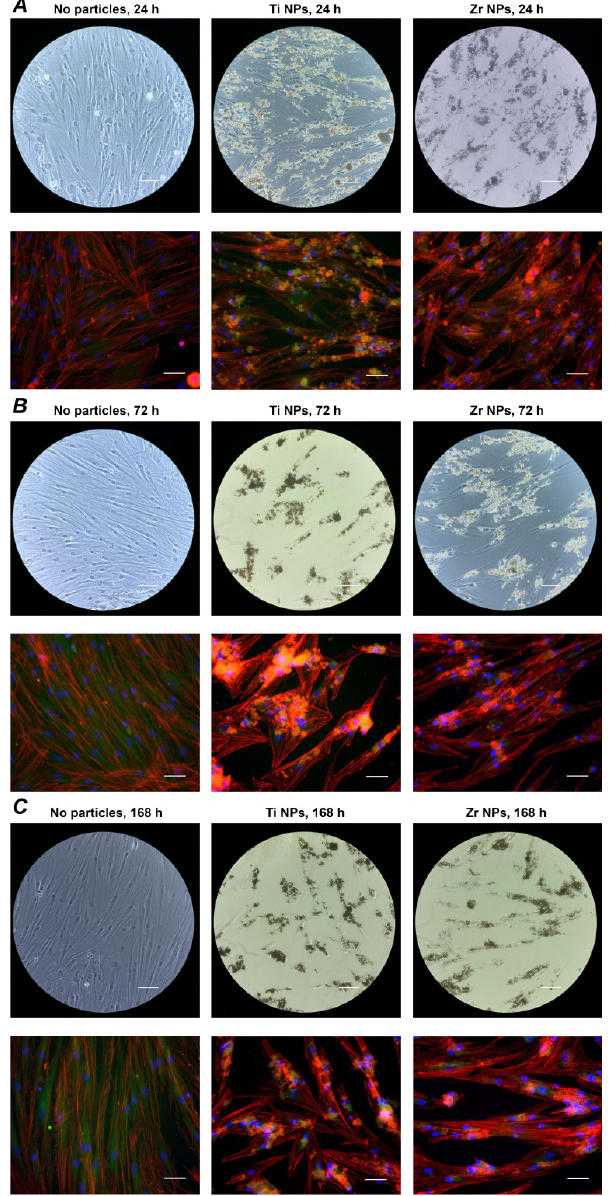
Figure 3. Focal adhesion staining of hG-MSCs cultured with or without NPs. The hG-MSCs were cultured in the absence or in the presence of Ti NPs or Zr NPs at a concentration of 250 µg/mL for 24 h ( A ), 72 h ( B ), or 168 h ( C ) and the cells were stained with a focal adhesion staining kit. F-actin was stained with TRITC-conjugated phalloidin (red), the focal adhesions with anti-vinculin and FITC-conjugated secondary antibody (green), and the nucleus with DAPI (blue). The scale bars correspond to 20 µm. correspond to 20 µ